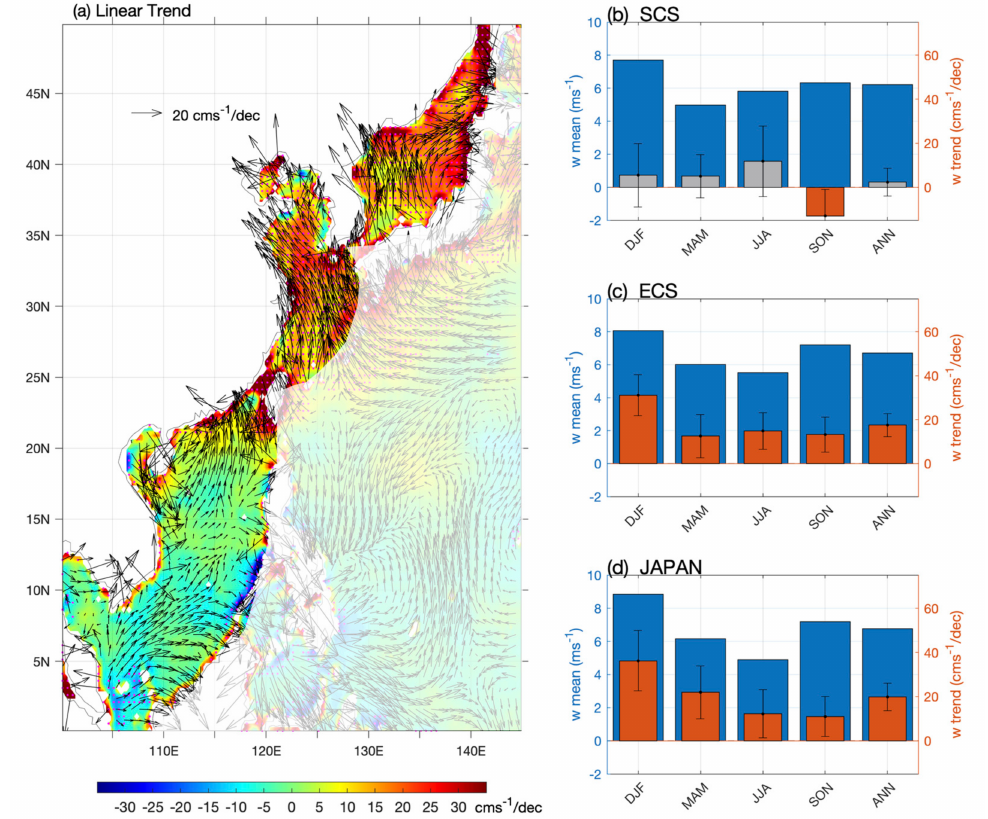
Figure 11. ( a ) Linear trends of annual-mean surface wind speed and vector subsetted from Figure 8a for the East Asian marginal seas. The magenta dotted areas denote the linear trends of wind speed that are significant at the 90% confidence interval. ( b – d ) Bar plots of the basin-averaged mean values (blue bars, left y -axis) and linear trends (red and gray bars, right axis) of wind speed in four seasons: December-January-February (DJF), March-April-May (MAM), June-July-August (JJA), and September-October-November (SON) and the total annual mean (ANN) for ( b ) A SCS: the South China Sea; ( c ) ECS: the East China Sea; and ( d ) JAPAN: the Sea of Japan. Error bars denote the upper and lower limits of the 90% confidence intervals. Linear trends that are statistically significant (not significant) are colored by red